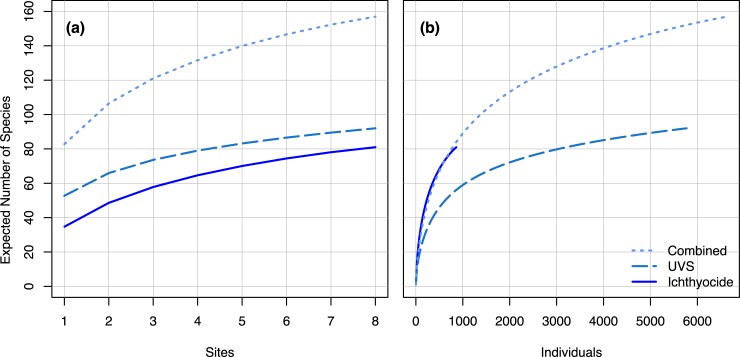
Rarefaction curves for UVS transects, ichthyocide stations, and combined results based on (a) sites and (b) individual fishes observed.